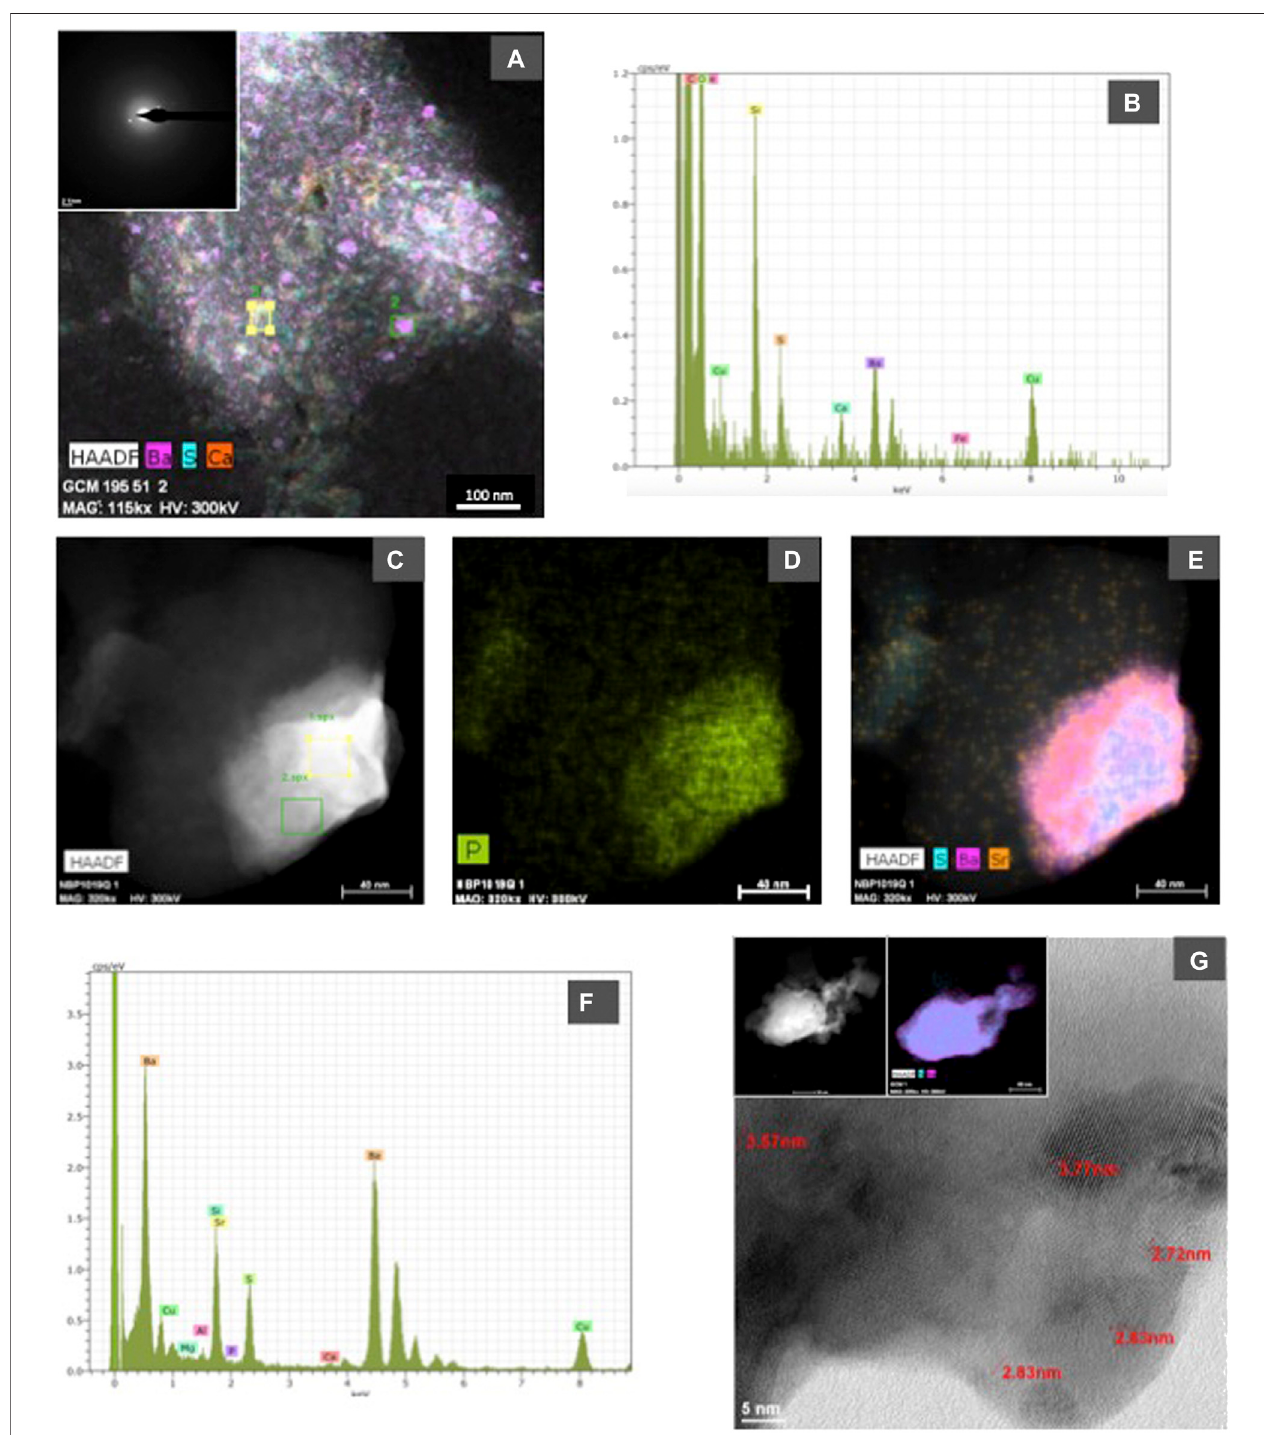
FIGURE 6 | (A) High Angle Annular Dark Field (HAADF) STEM image and corresponding EDX maps showing the distribution of S, Ba and Ca in an organic aggregatefromsampleGCM195(IndiansectoroftheSouthernOcean).Intheupperleftcorner,aselectedareaelectrondiffraction(SAED)imageobtainedbyHRTEMis includedtoshow thepoorcrystallinityofthenanometer-sizedparticleswithbarite composition; (B) representativespectrum(indicated intheHAADFimage assquare 2) showing the barite composition of nanometer-sized particles; (C) , (D) , and (E) show HAADF-STEM images and corresponding EDX maps of P (D) and Sr, S, and Ba (E) inabariteparticlefromNBP1019sample; (F) representativeEDXspectrum fromthebariteparticleshowninphotographc.Analyzedareacorrespondstosquare 2inthatphotograph,theSrpeakshowsitsenrichmentinthisgrain; (G) showsalattice-fringeimagefromsampleGCM124inwhichd-spacescharacteristicofbariteare indicated: 3.77 Å (201),3.57 Å(002),2.83 Å(112), and 2.72 Å (020).In upper left side,aHAADF-STEM image and correspondingEDX maps (S and Ba)ofthe analyzed particle are included.